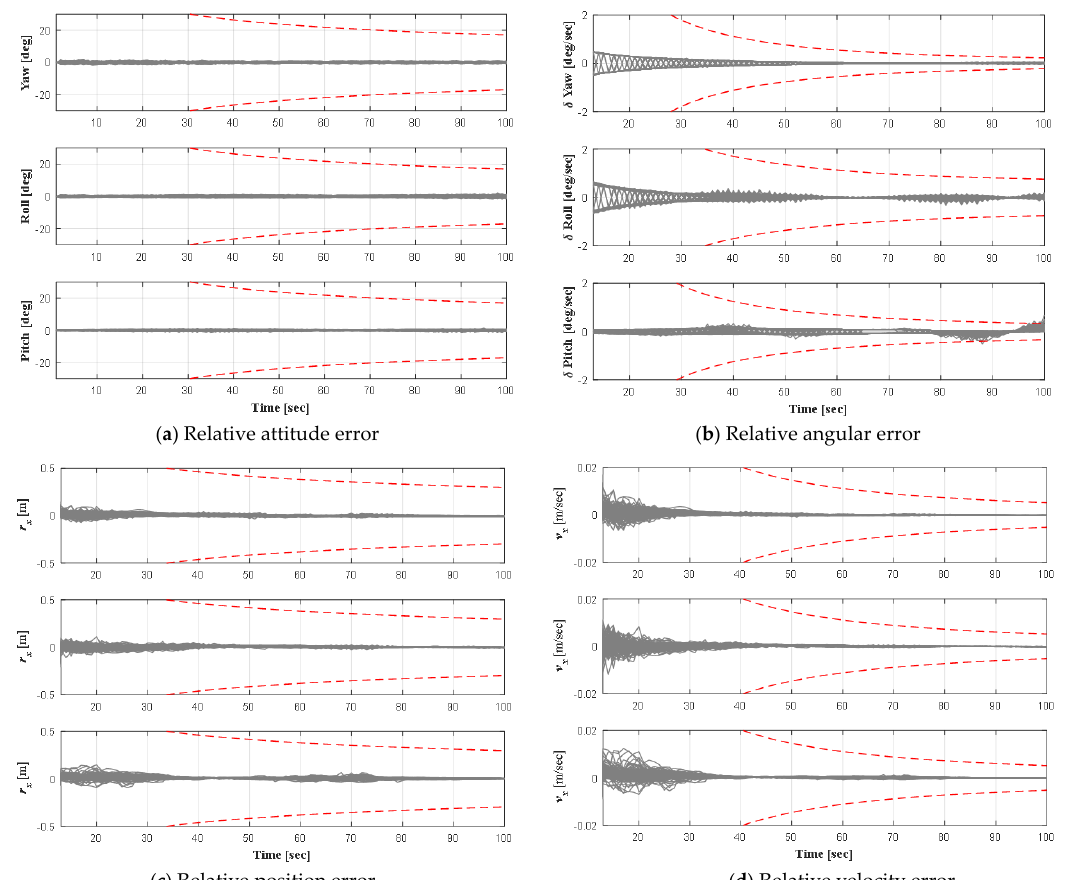
Figure 19. Experimental results of the relative attitude, angular velocity, position, and velocity. The results indicate that our algorithm converges within 40 s. Statistics of the state errors are shown in Table 2 below. Table 2. Statistics of state errors.